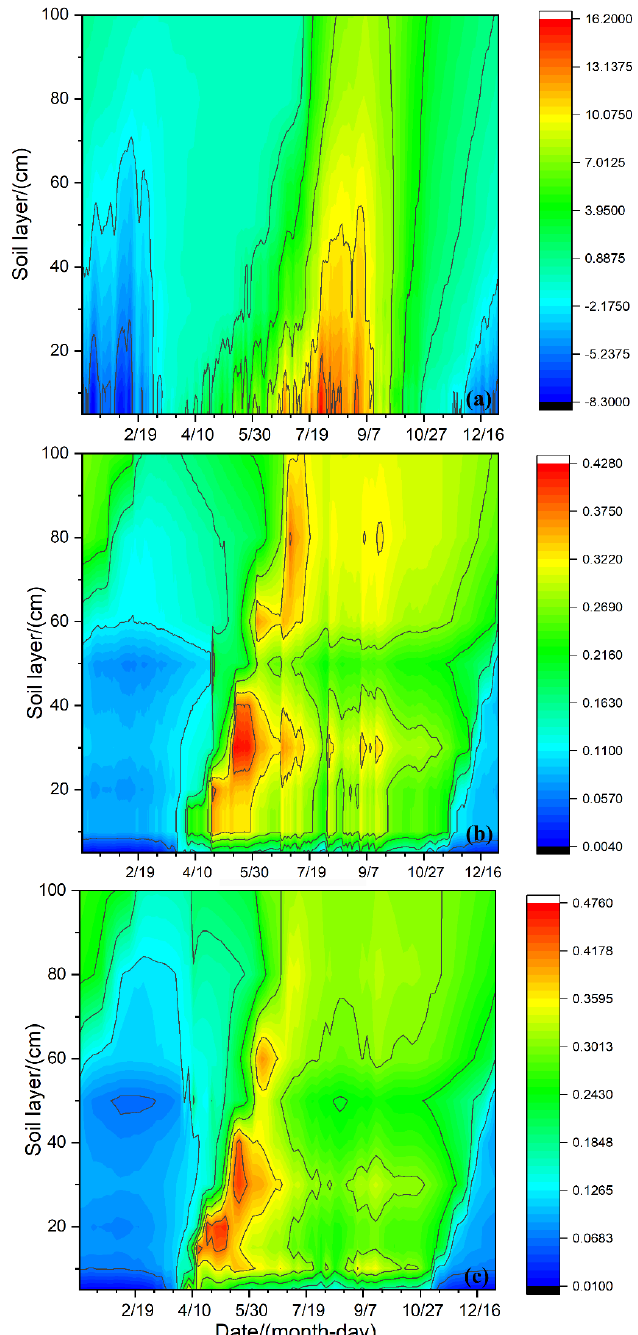
Figure 3. Variations of soil temperature ( a ), water content in non-degraded shrub ( b ) and water content in degraded shrub ( c ) during the year. content in degraded shrub ( c ) during the